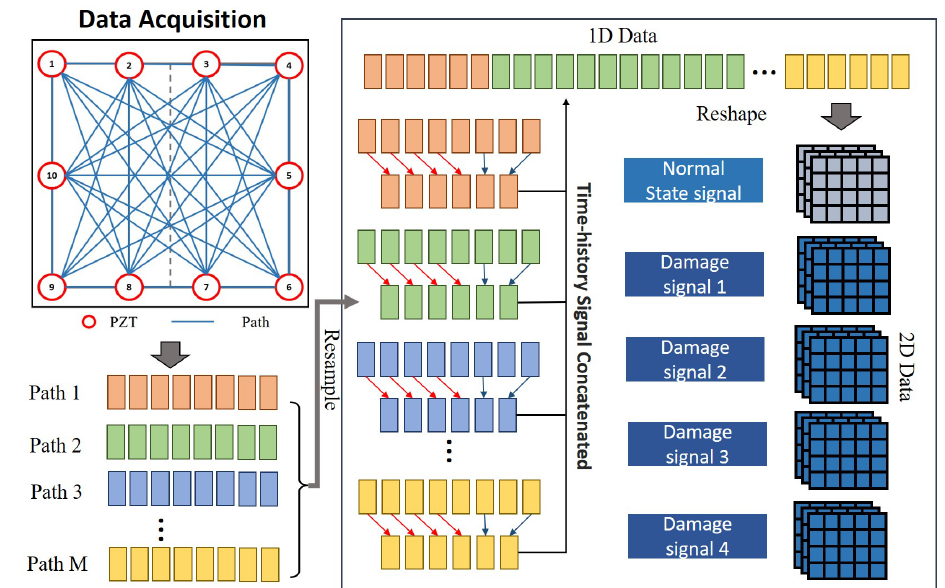
Figure 3. Flowchart of the proposed